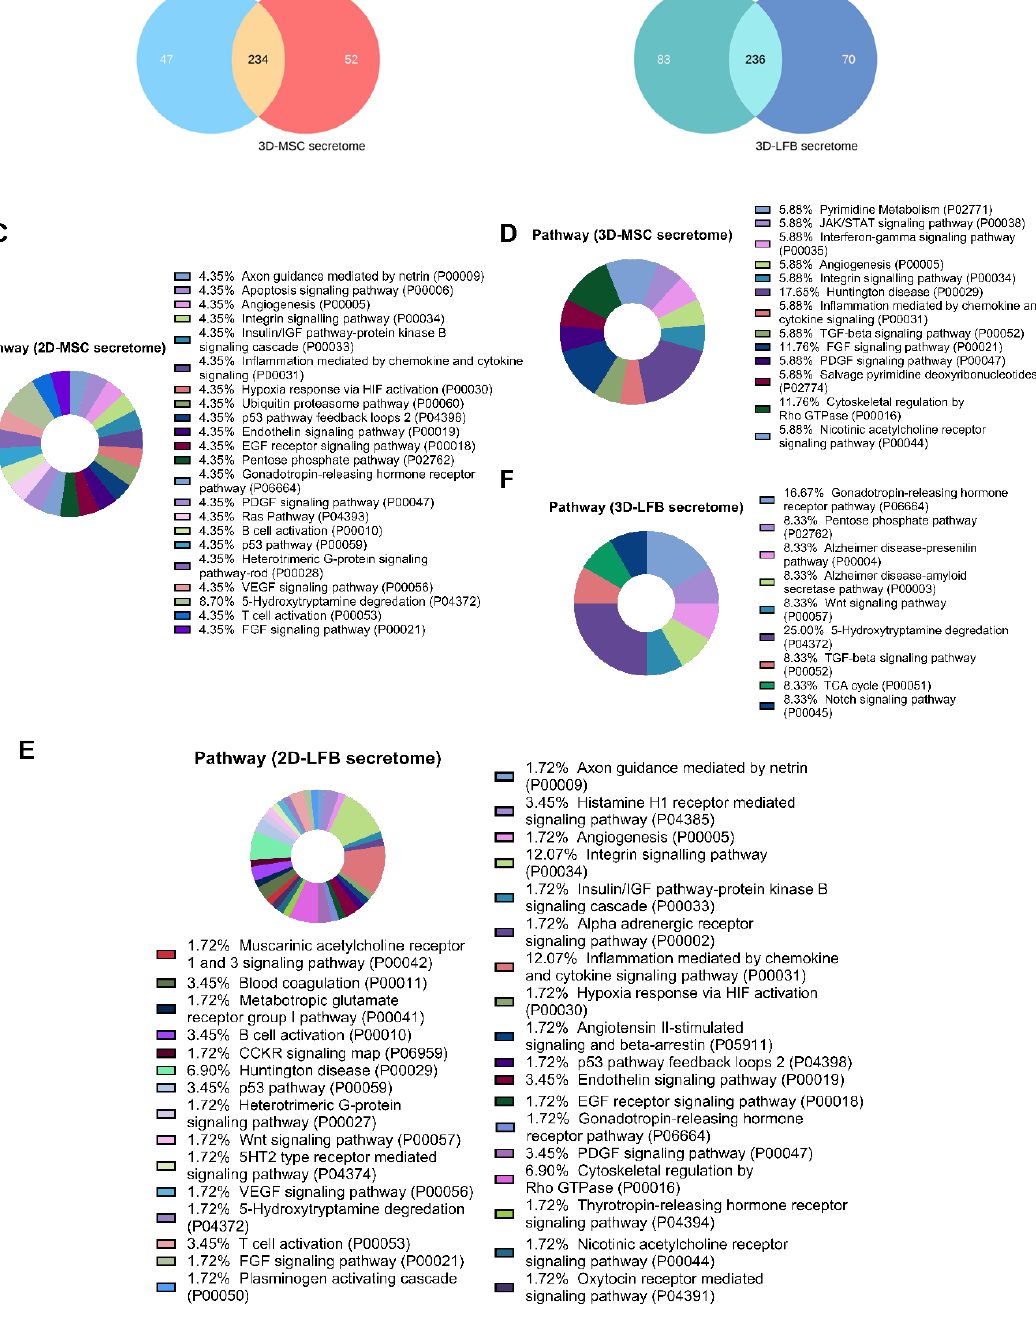
Figure 3. Proteomic analysis of multipotent mesenchymal stromal cell (MMSC) and lung fibroblast (LFB) secretomes. ( A ) Venn diagram of proteins identified in secretome from MMSC 2D/3D cultures. ( B ) Venn diagram of proteins identified in secretome from LFB 2D/3D cultures. ( C ) Gene Ontology pie chart of pathways associated with proteins identified only in the secretome from MMSC 2D cell culture. ( D ) Gene Ontology pie chart of pathways associated with proteins identified only in the secretome from MMSC 3D cell culture. ( E ) Gene Ontology pie chart of pathways associated with proteins identified only in the secretome from LFB 2D cell culture. ( F ) Gene Ontology pie chart of pathways associated with proteins identified only in the secretome from LFB 3D cell culture. MMSC, multipotent mesenchymal stromal cell; LFB, lung fibroblast.